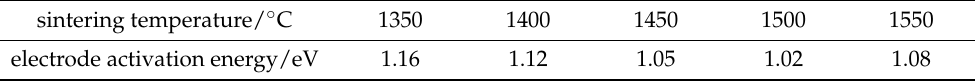
Figure 11. Arrhenius curves of Pt/YSZ electrodes at different sintering temperatures. Table 2. Activation energy of electrode reaction at different sintering temperatures.